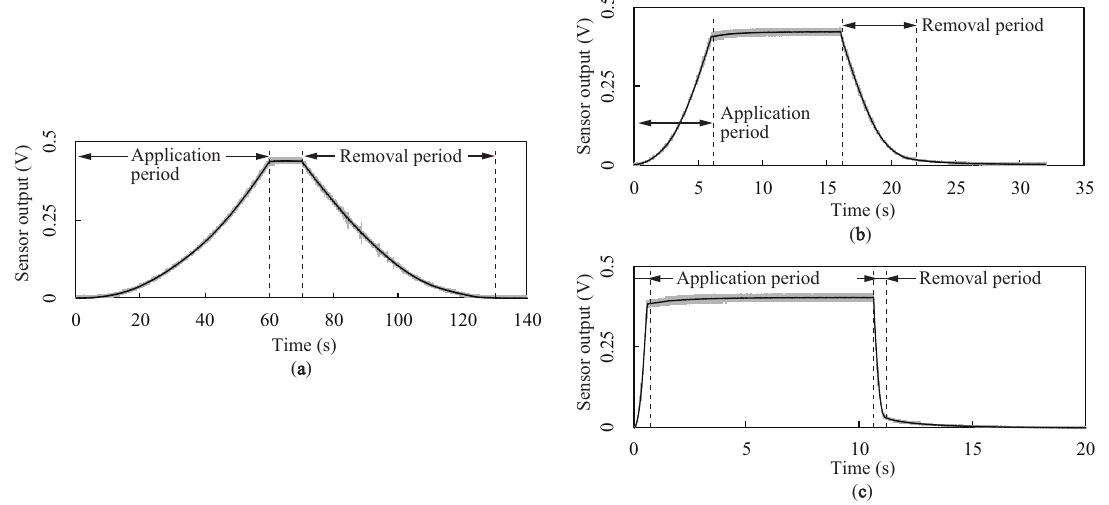
Figure 7. Sensor output versus time for three different contact speeds: ( a , b , c ) Sensor outputs with three different contact speeds V = 0.1, 1, and 10 mm/s, respectively.